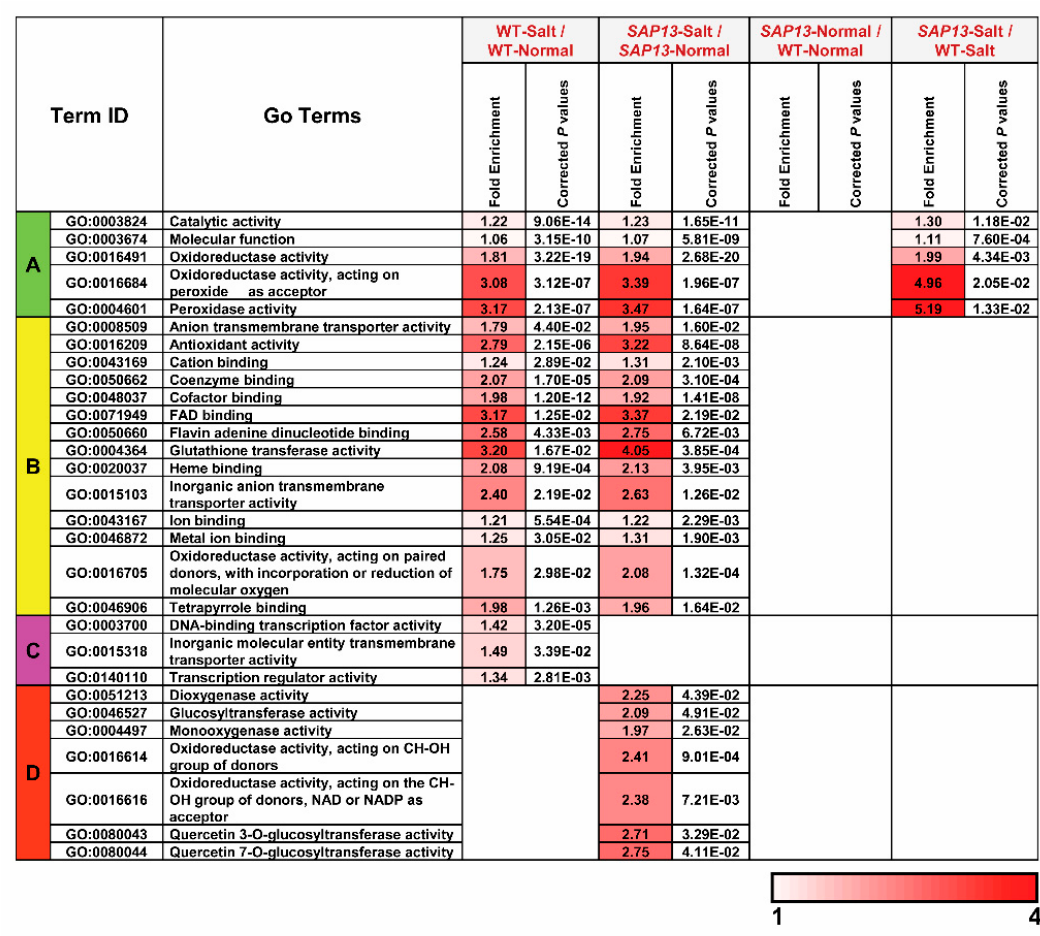
Figure 8. Molecular function in GO enrichment analysis of all DEGs in four types of comparisons of WT and PtSAP13 -overexpressing plants. Only significantly enriched terms with corrected p -value < 0.05 are indicated.